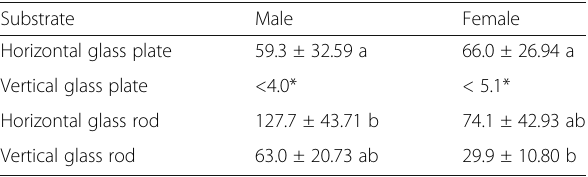
Letters indicate statistical differences in male or female traction forces between test substrates according to Kruskal-Wallis one-way ANOVA on ranks, Tukey-test, p < 0.05, males: H 2,13 = 6.7, p = 0.034; females: H 2,13 = 7.3, p = 0.025; *, no